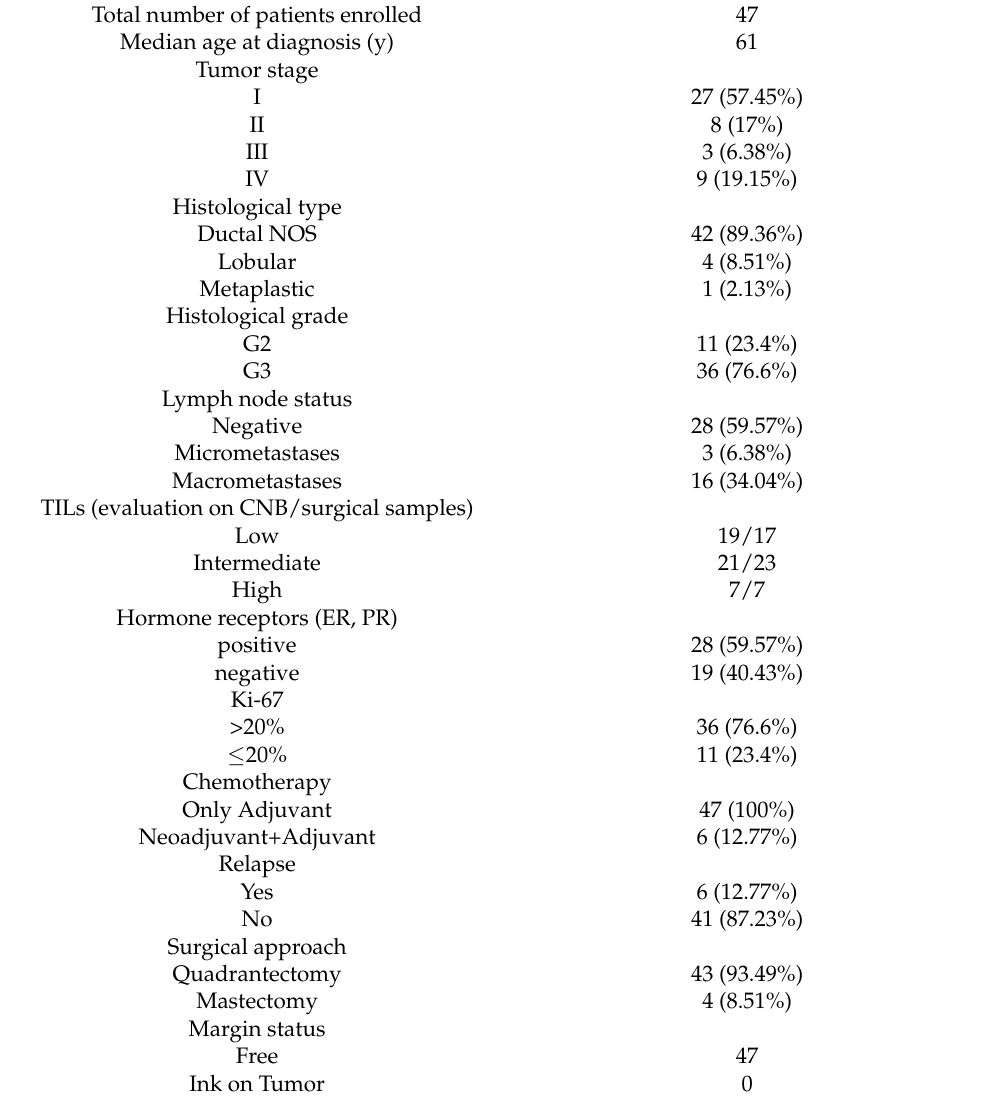
Table 1. Patients’